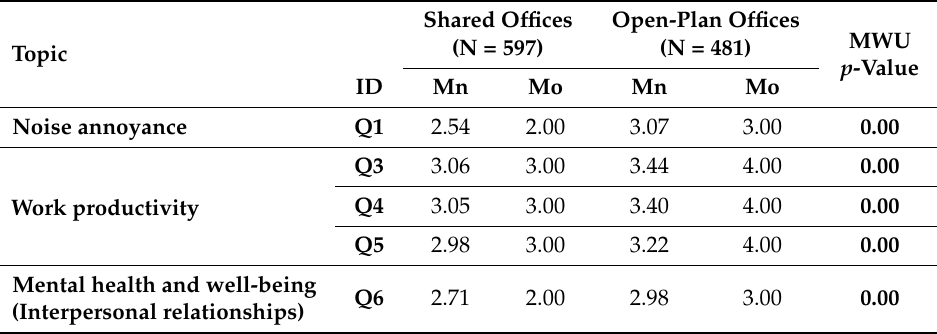
Table 3. Mean (Mn) and mode (Mo) values of the answers on noise annoyance, work productivity, and mental health and well-being related to ISN, for shared offices and open-plan offices, and two-tailed p -values of significance for the differences between the two office types, according to the MWU Test. Any statistically significant differences, with p -value < 0.05, are reported in